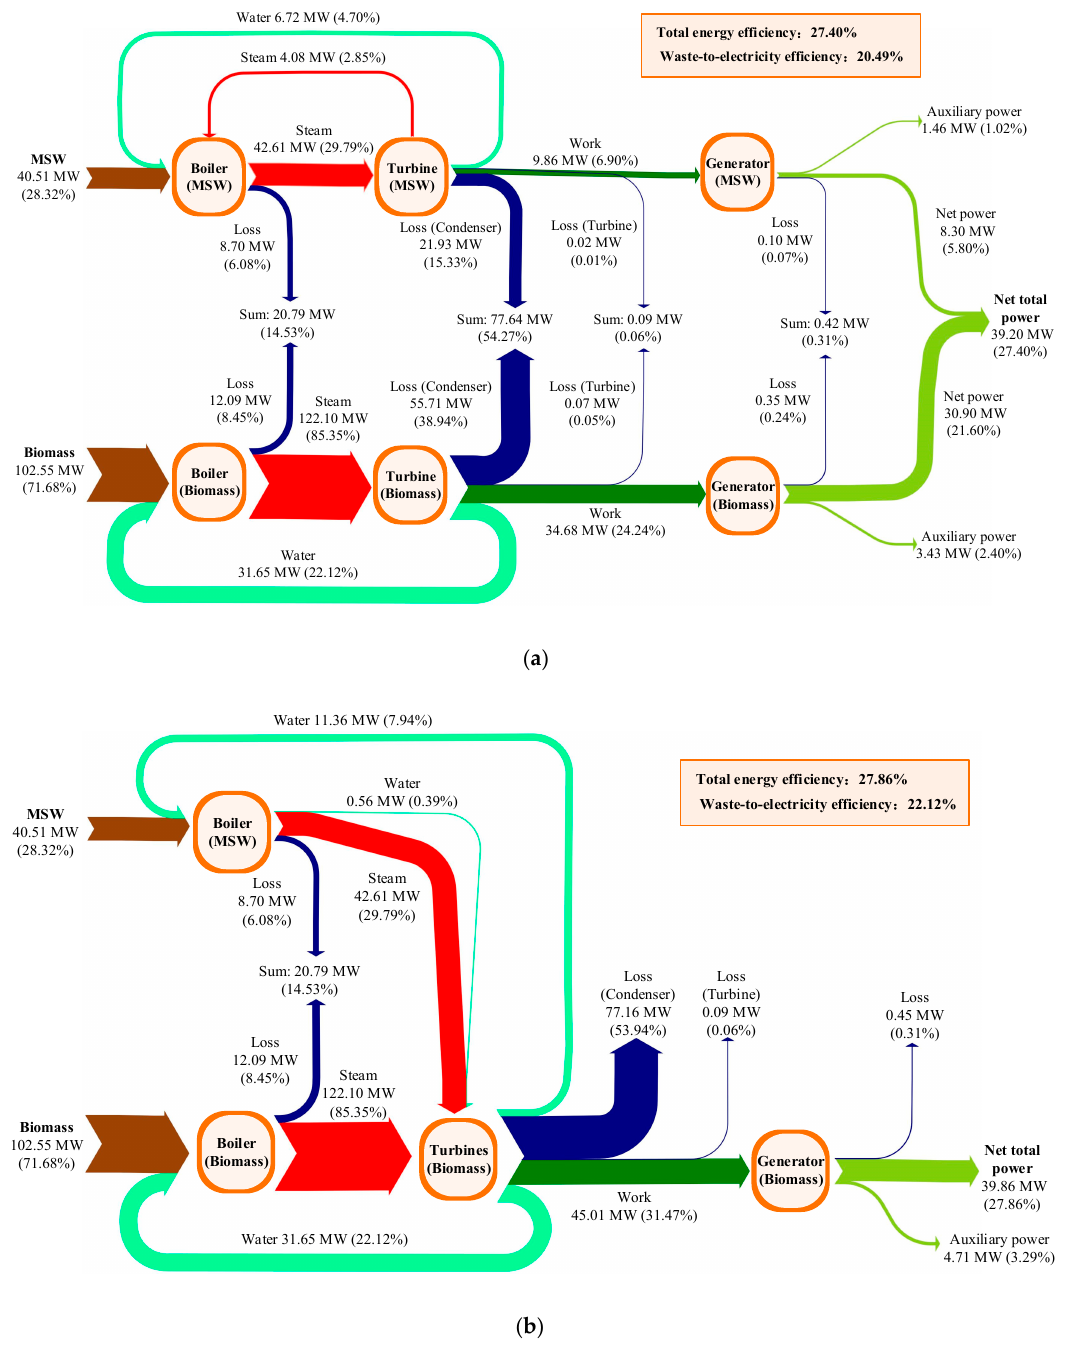
Figure 4. Energy flows of the two schemes. ( a ) Separate scheme. ( b ) Integrated scheme.